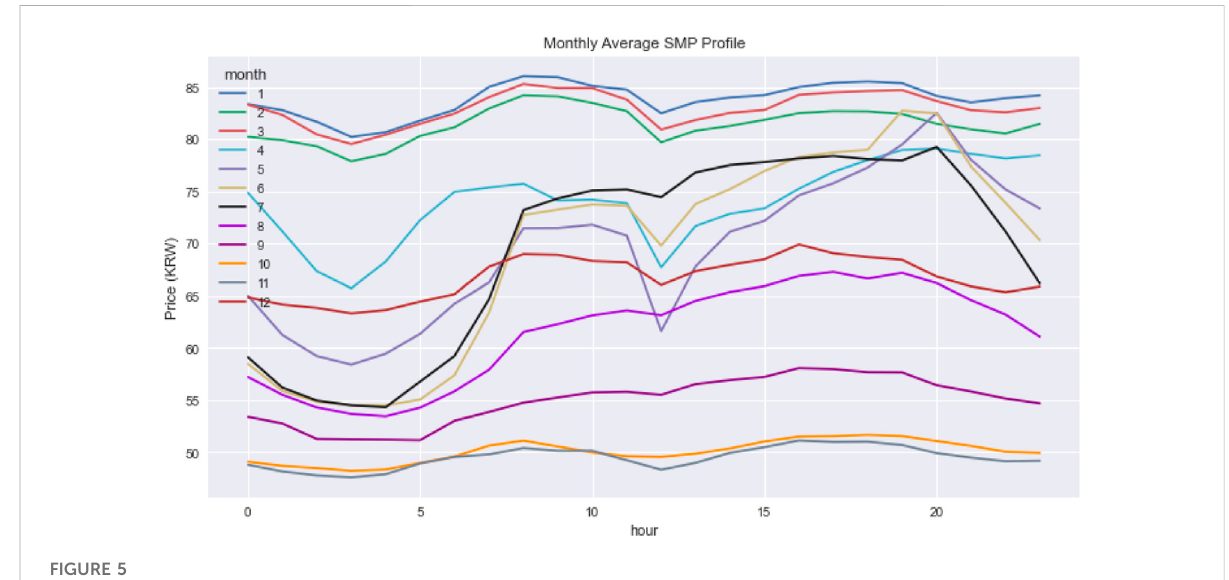
FIGURE 5 Monthly average market price pro fi le.